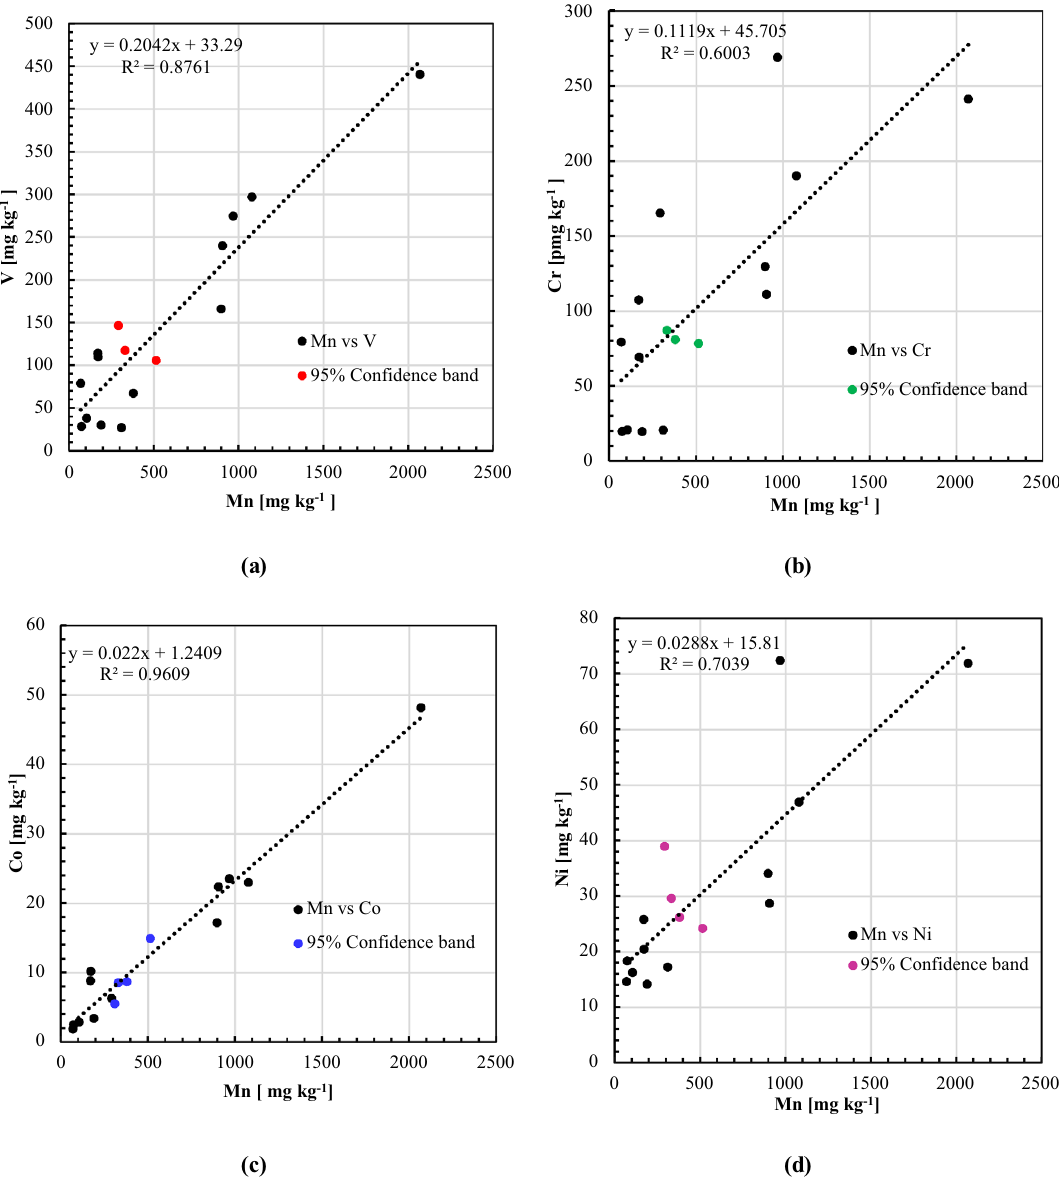
Fig. 15 Normalization method between manganese and vanadium ( a ), manganese and chromium ( b ), manganese e cobalt ( c ), manganese e nickel ( d ) in Borgo